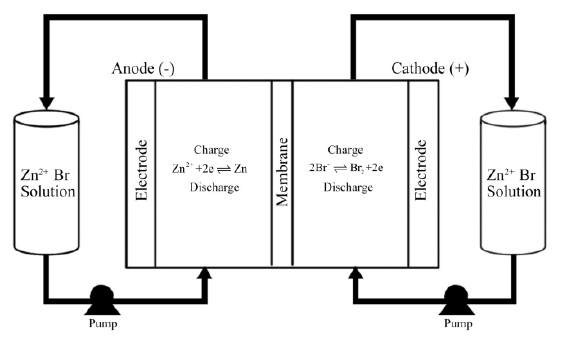
Figure 1. Schematic diagram of the ZnBr 2 single cell .